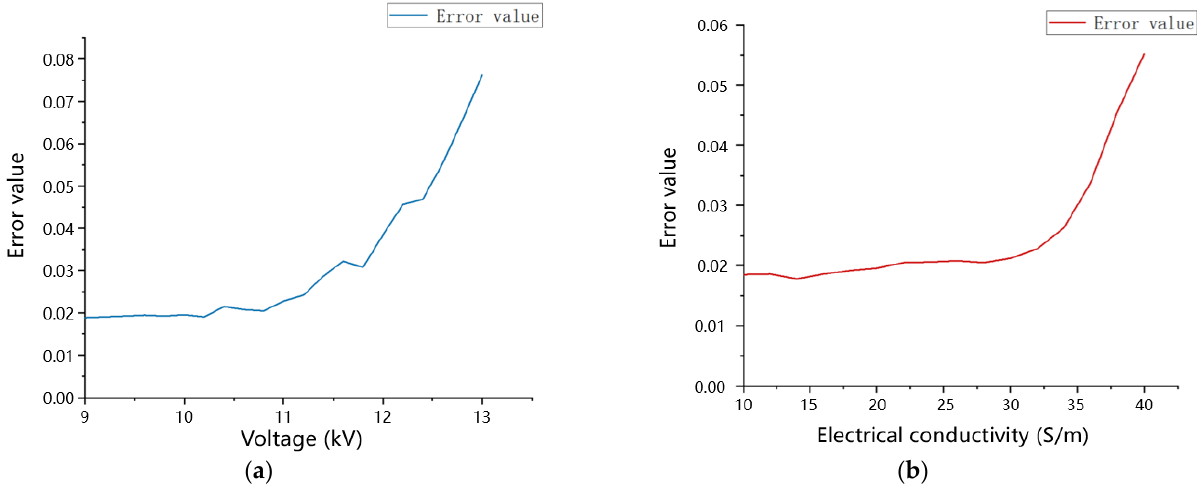
Figure 8. Changing the cable operating voltage and impurity conductivity error analysis, ( a ) Relationship between changes in cable core voltage values and calculation error values, ( b ) Relationship between changes in impurity conductivity and calculation error values.